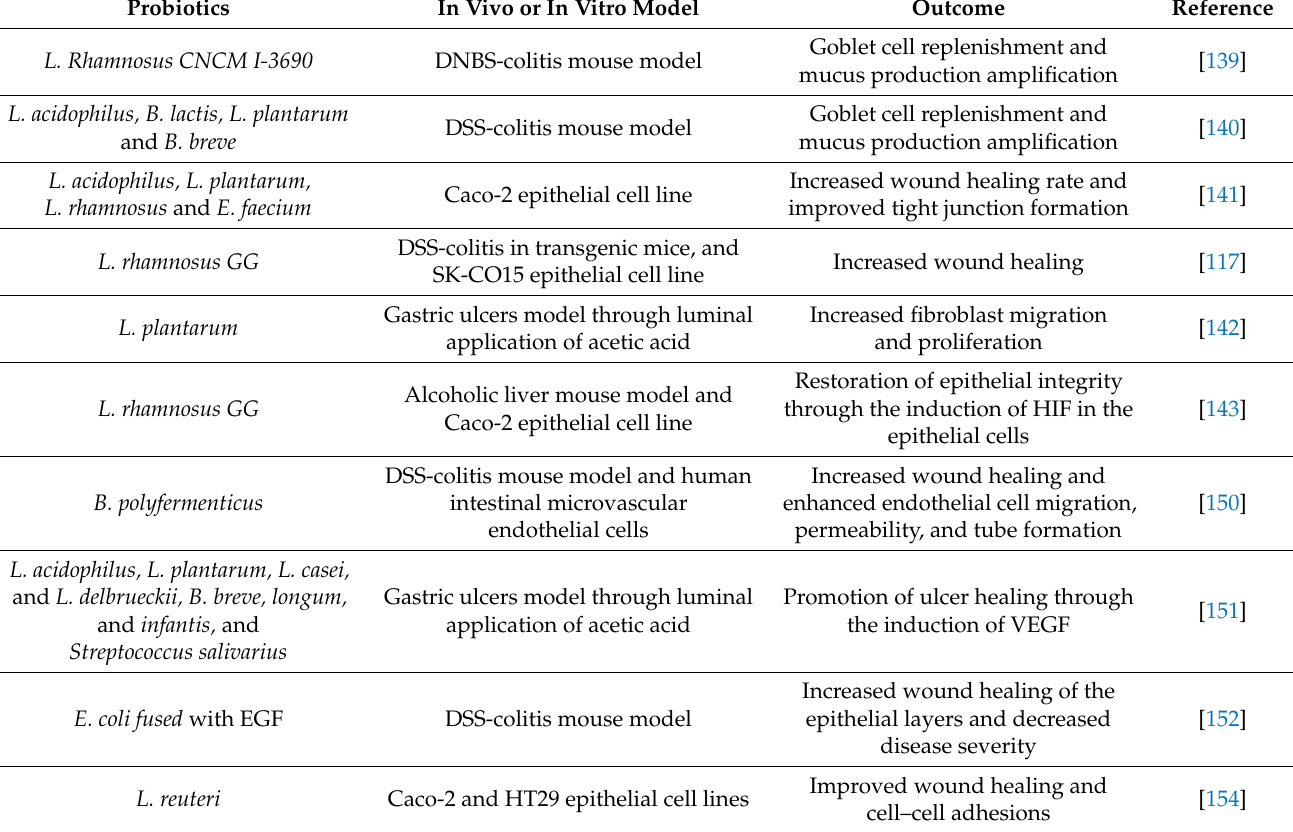
Table 2. The effects of probiotics on intestinal wound